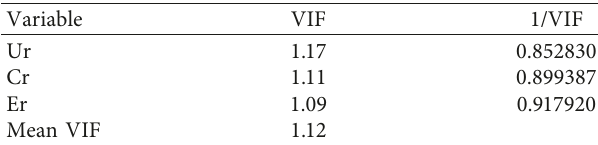
economic growth rate and other independent variables.